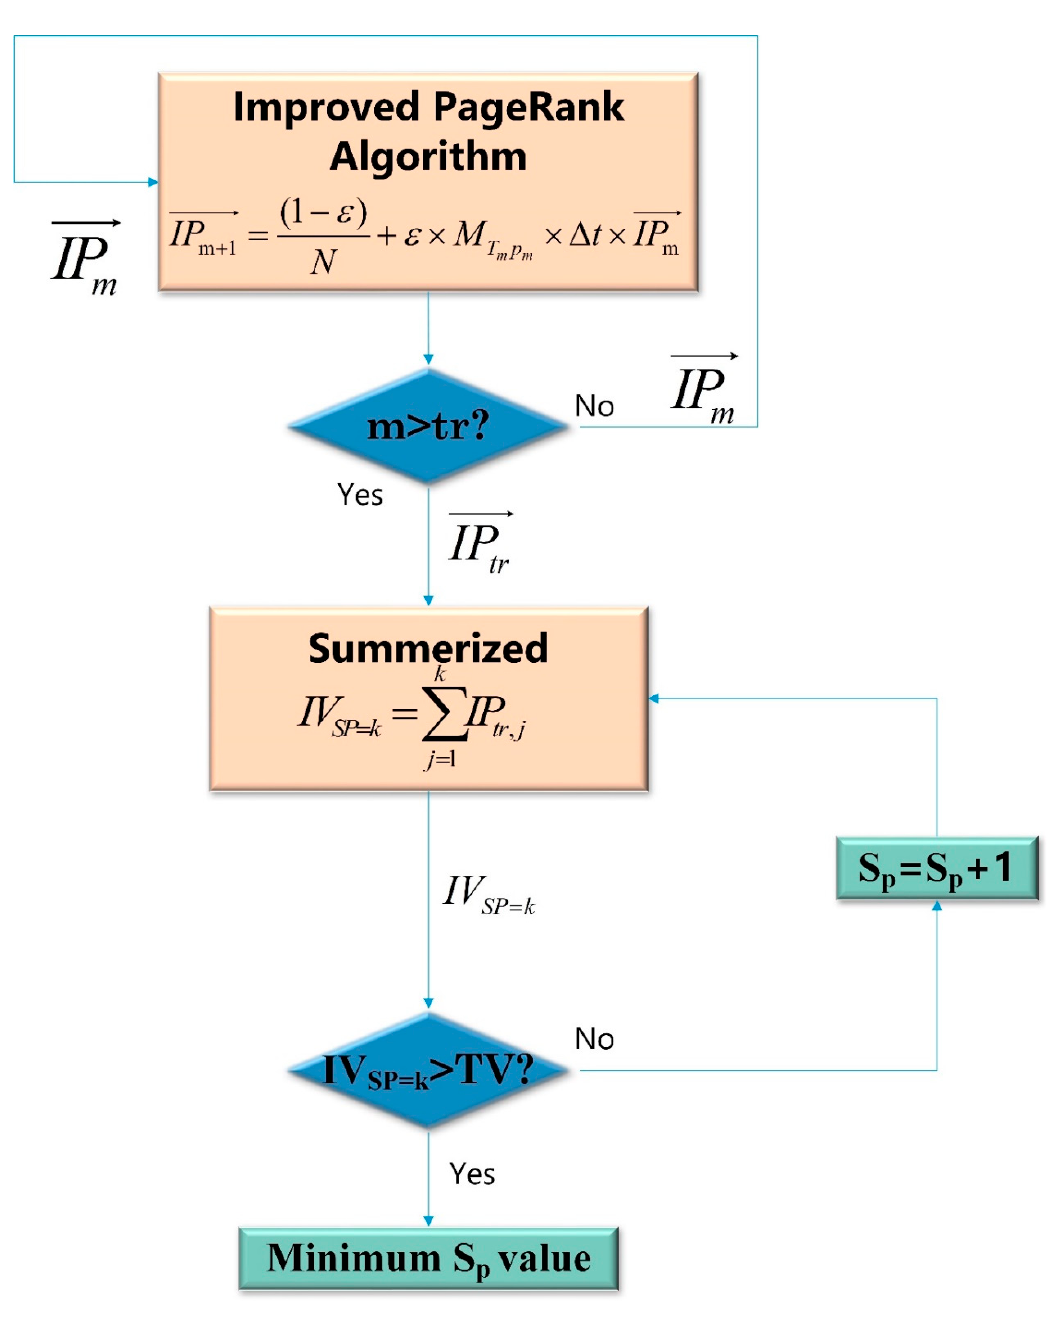
Figure 5. The improved PR algorithm and optimal S p